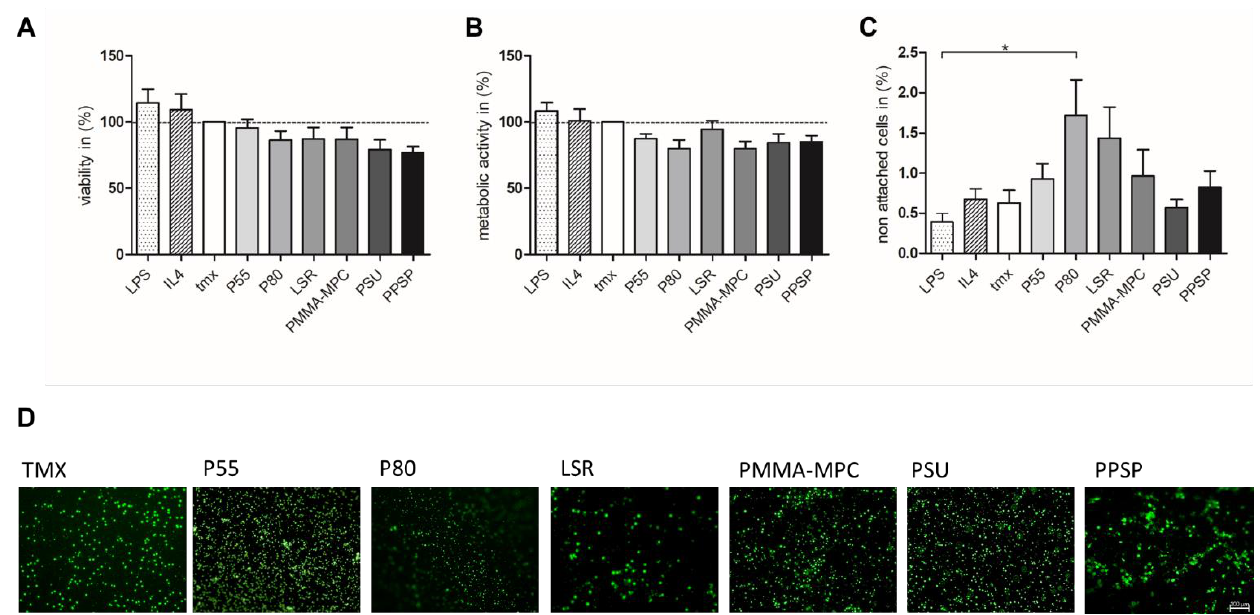
Figure 2. Decreased monocyte adhesion on thermoplastic polyurethane (TPU) and liquid silicone rubber (LSR) with only minor effects on cell viability and metabolic activity. Then, 5 × 10 5 cells were incubated on the materials ( A ) Viability was measured after 12 h by treating the cells with 10% CellQuanti-BlueTM reagent and incubated for 5 h at 37 °C. ( B ) Metabolic activity was calculated by measuring the optical density of the cell suspensions every hour. ( C ) Non-attached cells were determined after 12 h of incubation by collecting the supernatants and counting the non-attached cells with Casy cell counter. ( D ) 1 × 10 6 cells were incubated on the different materials and analyzed after 12 h by microscopy by calcein AM. Magnification, × 2400. Data are represented as mean + SE Mean of six independent experiments. Significant results are indicated as * p < 0.05; ** p < 0.01; and *** p < 0.001 .